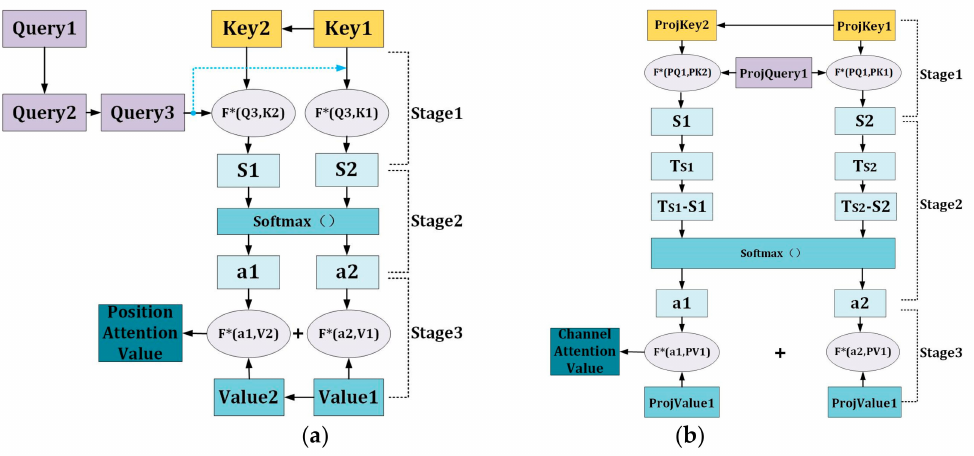
Figure 7. The detailed implementation process of Position Attention Mechanism (PAM) and Channel Attention Mechanism (CAM). ( a ) PAM; ( b )